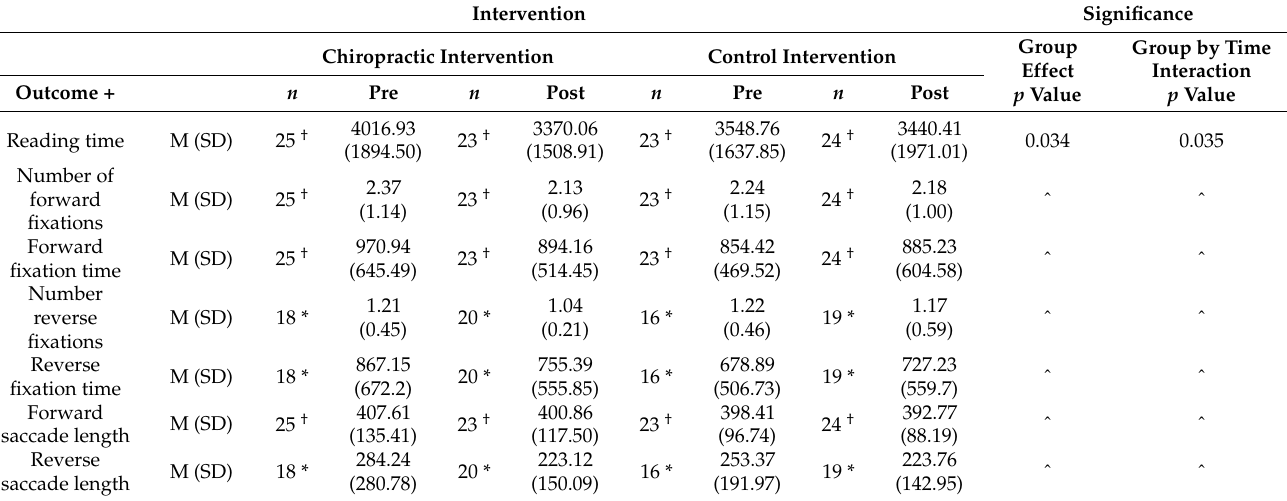
Table 3. Reading task: Outcome measure results of study participant’s pre- and post-chiropractic intervention versus active